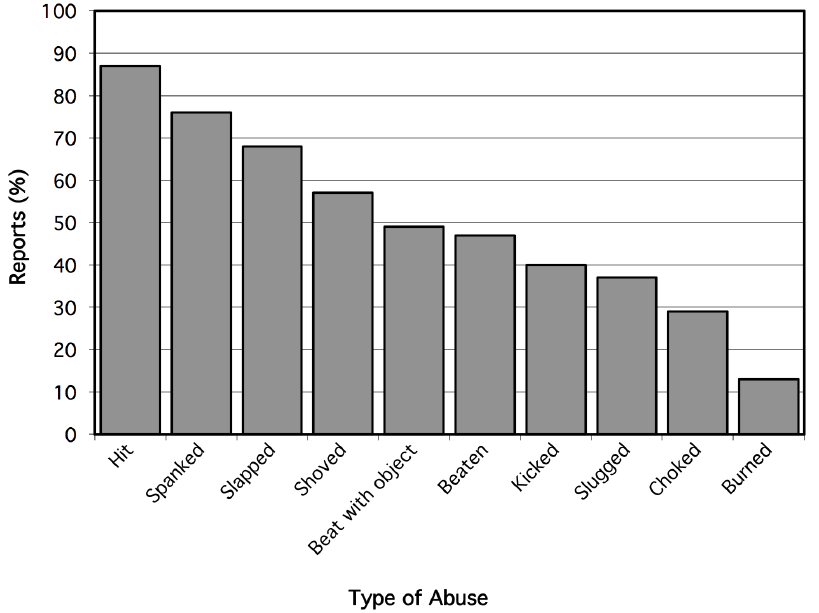
Figure 1. Types of childhood physical abuse reported by young HIV-negative gay and bisexual men in Vancouver, Canada (n=287).